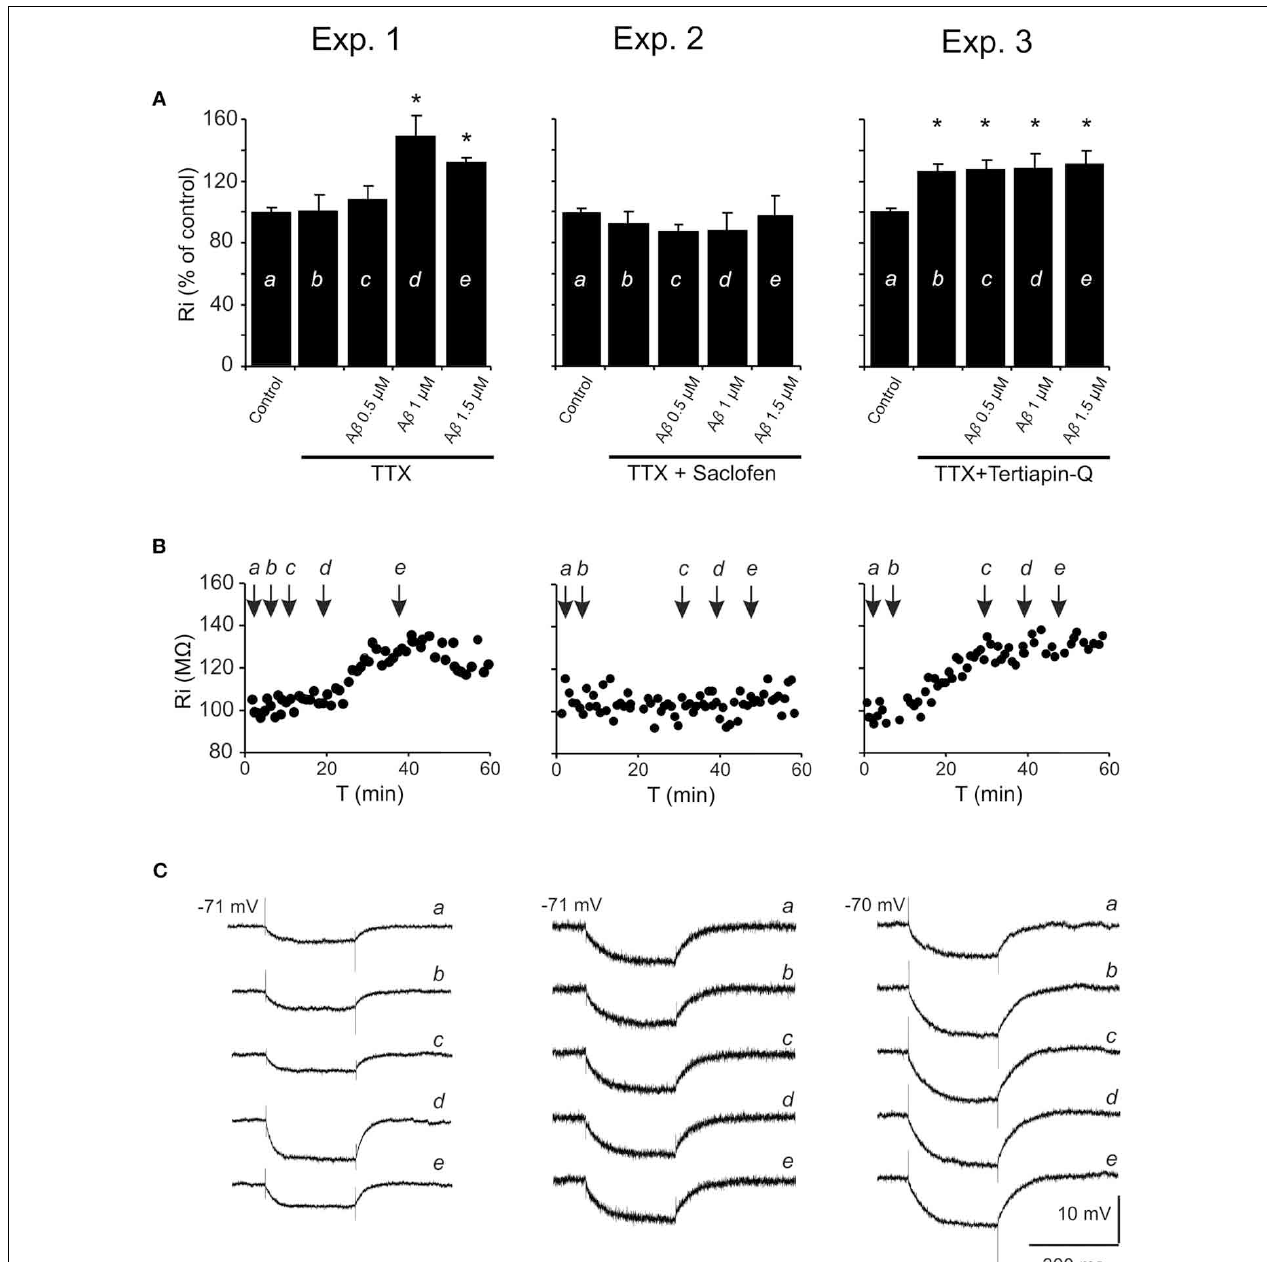
FIGURE 7 | Histograms with Ri mean values in CA3 pyramidal neurons for increasing A β 25 – 35 concentrations. (A) Normalized mean value of Ri as % of control after perfusion with three different A β 25 – 35 concentrations in three different experimental conditions (Exp. 1–3). In all cases, TTX pre-treatment (1 μ M; voltage-dependent sodium channel blocker) was unable to prevent A β 25 – 35 effects on Ri, suggesting a postsynaptic location